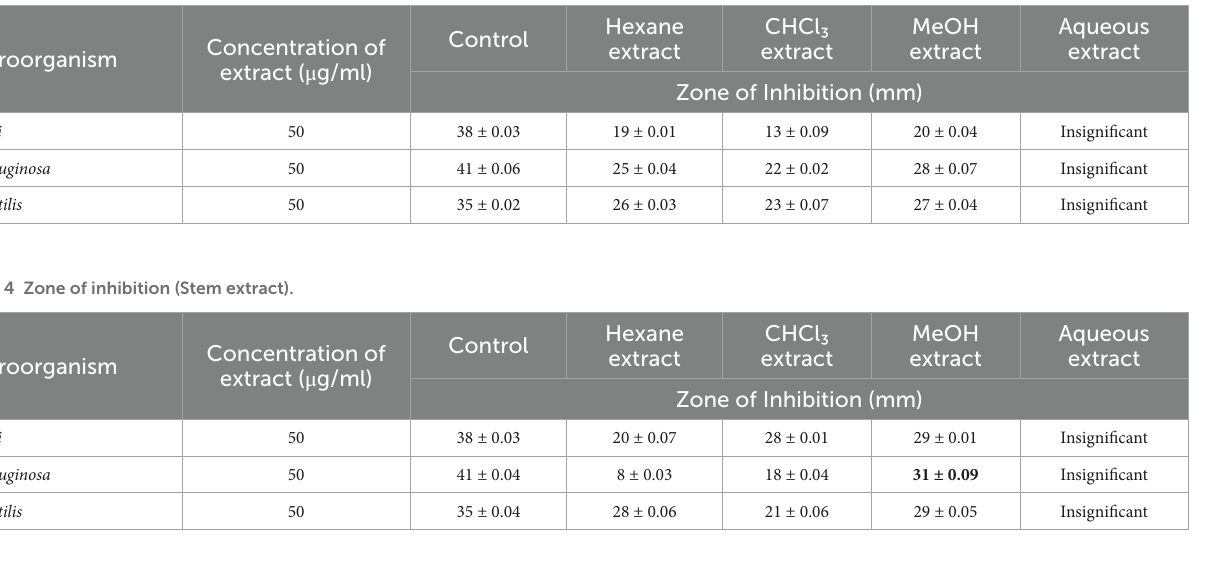
TABLE 3 Zone of inhibition (Leaf extract).